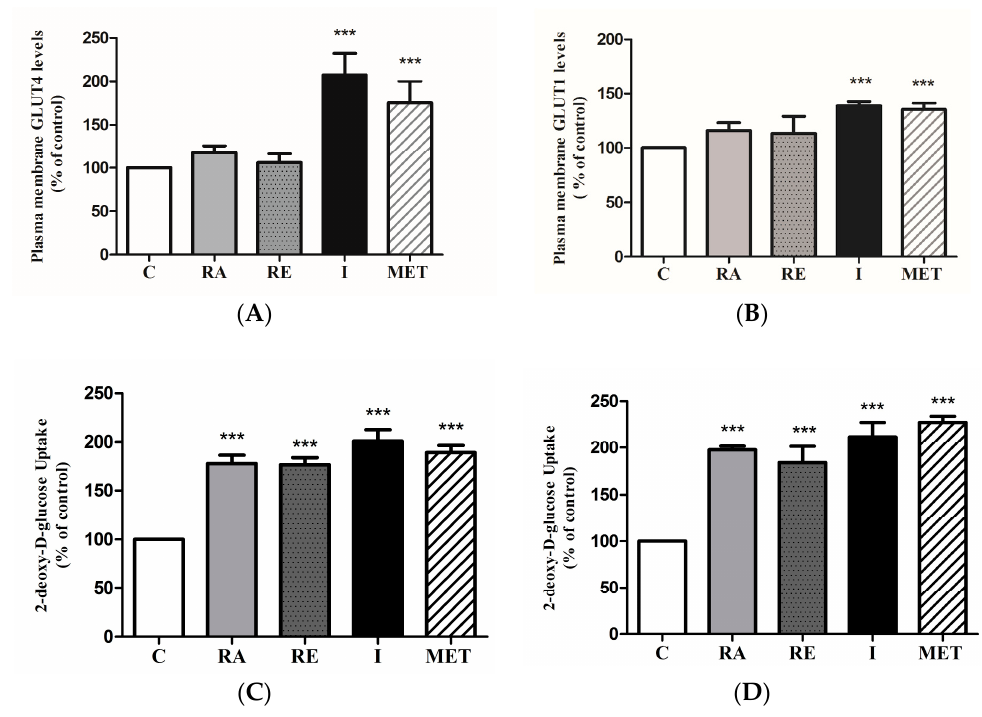
Figure 8. Effect of RA on plasma membrane GLUT levels and glucose uptake in GLUT-overexpressing cells. L6 GLUT4myc ( A , C ) or GLUT1myc ( B , D ) overexpressing cells were treated with 5 µM rosmarinic acid (RA) (4 h), 5 µg/mL rosemary extract (RE) (4 h), insulin (I) (100 nM, 0.5 h), or 2 mM metformin (MET) (4 h), followed by GLUT4 or GLUT1 plasma membrane transporter level measurements ( A , B ) or glucose uptake measurements ( C , D ). Results are mean ± SE of 5–7 independent experiments. *** p < 0.001 vs. control.